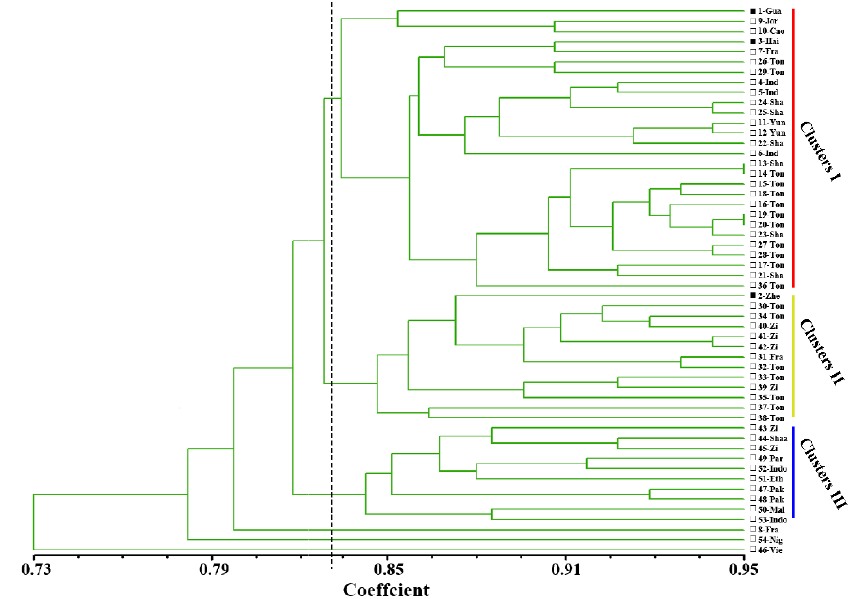
Figure 7. Dendrogram of 54 R. communis L. seed samples generated by the UPGMA cluster analysis based on RAPD markers.